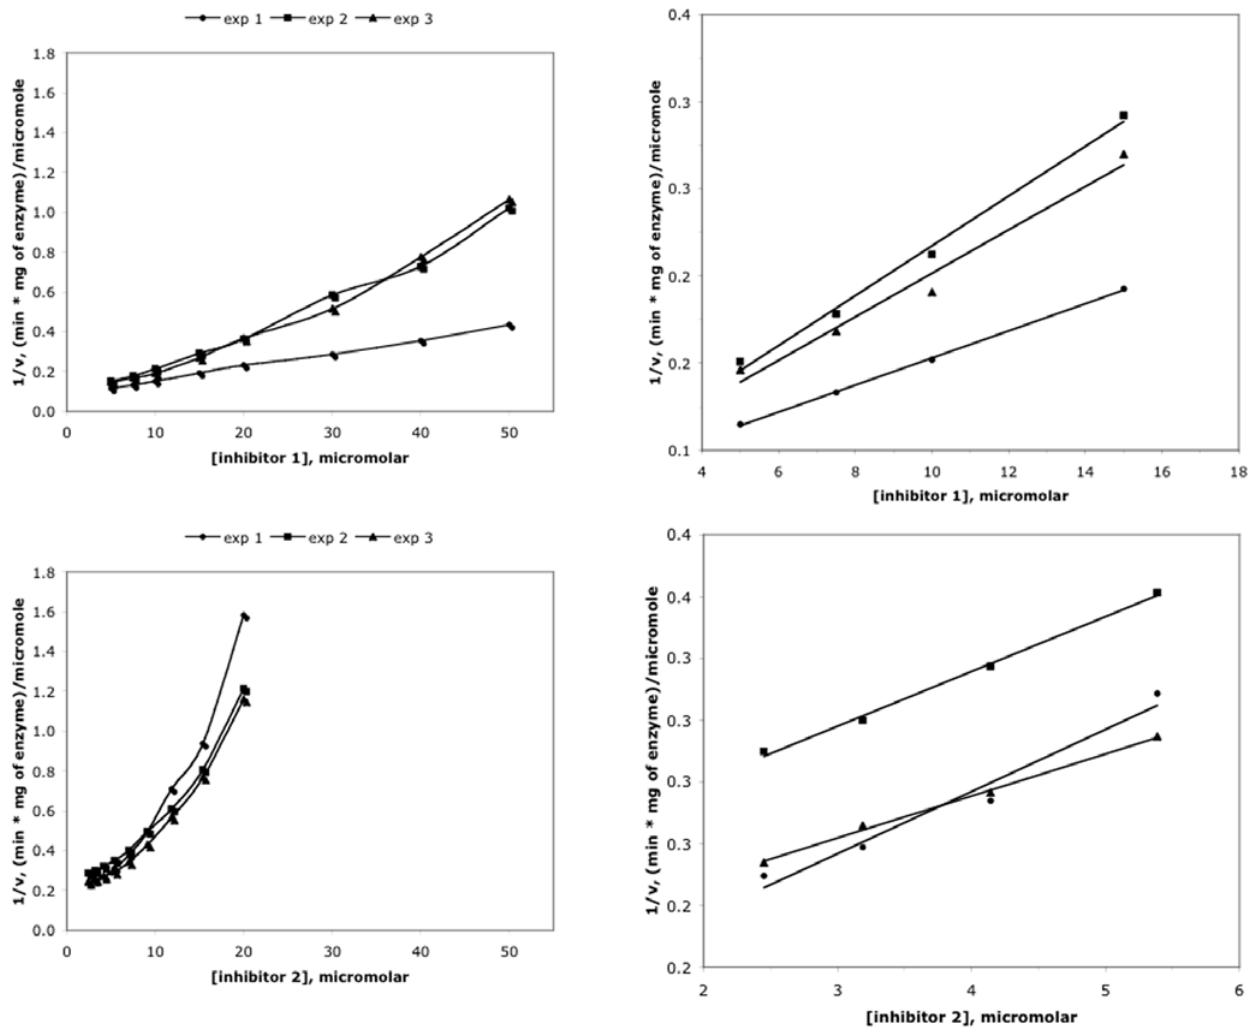
Figure 5. Dixon plots for inhibition of the botulinum neurotoxin serotype A endopeptidase by inhibitors 1 (upper panels) and 2 (lower panels). The right panels are the scale-up of the left